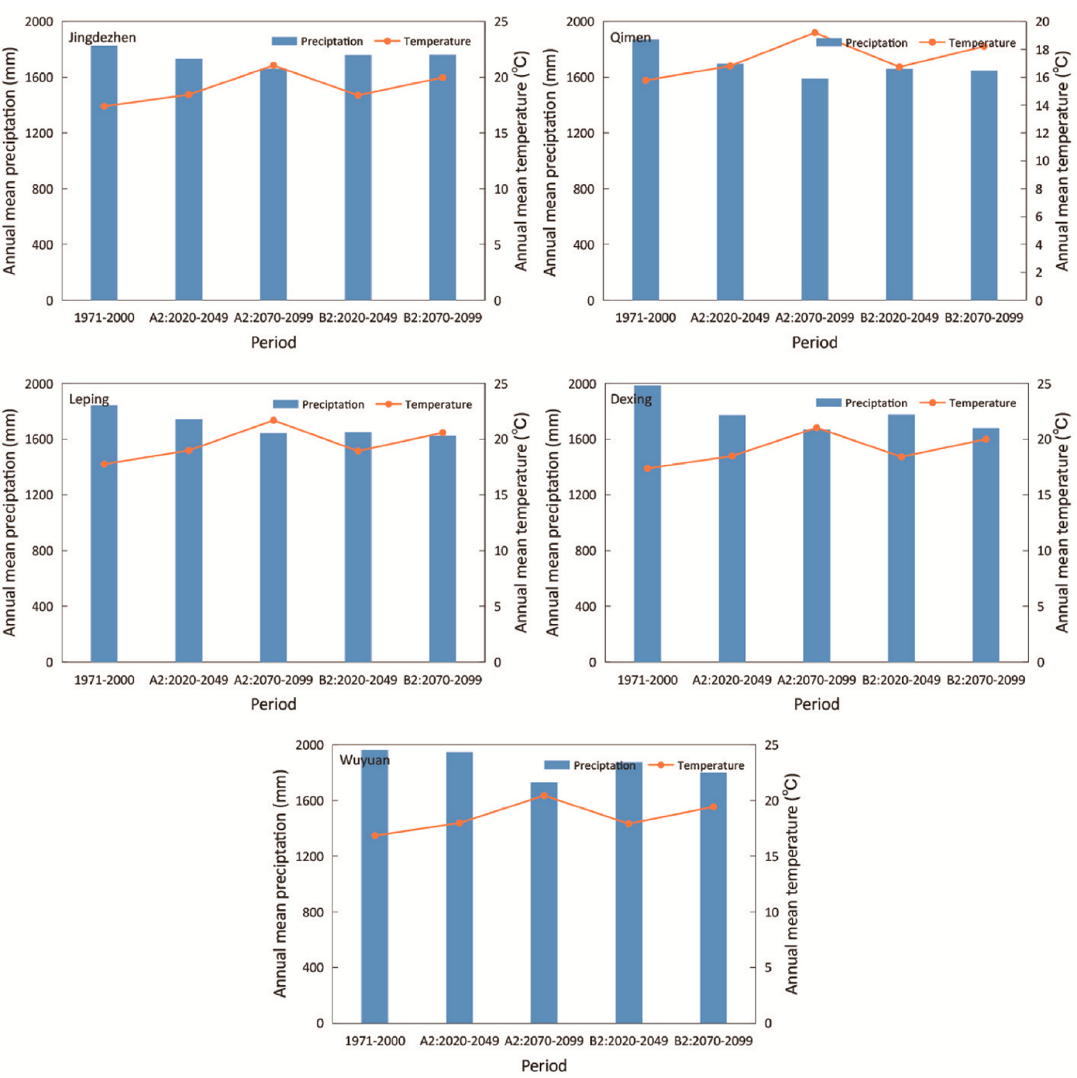
Figure 4. Annual mean precipitation and temperature for the two future periods in the A2 and B2 scenarios.